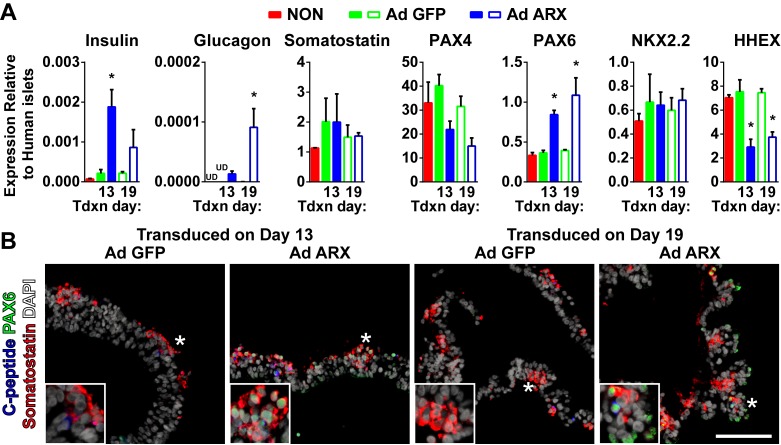
Fate Specification Factors in Ad ARX Treated ARX ko hESCs.(A) RT-qPCR of day 26 whole population samples examining the expression of three hormones and key transcription factors in ARX ko clone 1 cells treated with Ad GFP (green bars) or Ad ARX (blue bars) at an MOI of 2 on day 13 (filled bars) or 19 (open bars). * indicates p < 0.05 Ad GFP vs Ad ARX from a given transduction (Tdxn) day. N = 3 per group. (B) Immunostaining of PAX6 (green), somatostatin (red), and C-peptide (blue) in ARX ko cells differentiated to day 26 after transduction at day 13 or 19 with Ad GFP or Ad ARX. Inset is a ~3x enlarged portion from the region indicated by the star. Scale bar is 100 μm for all panels.